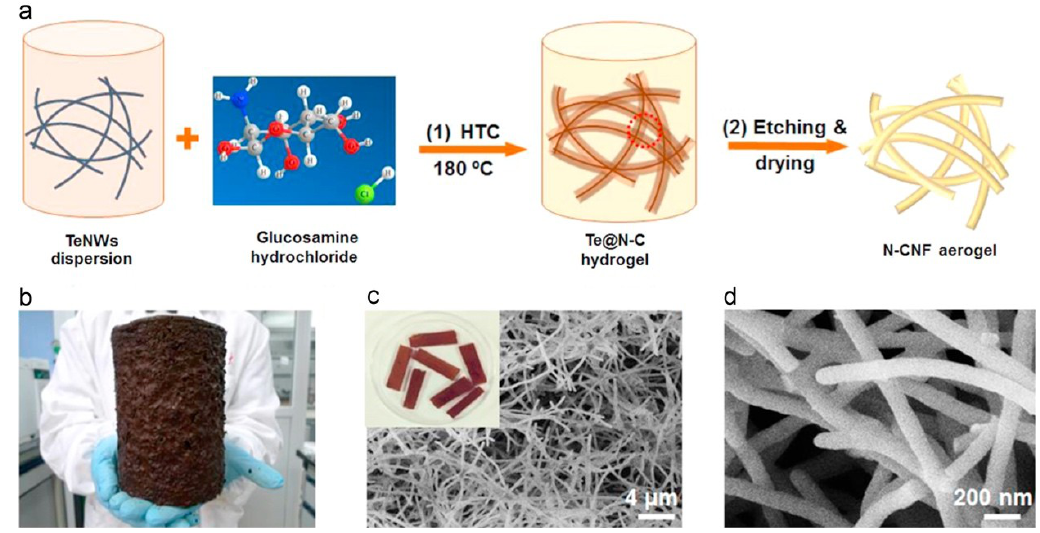
Figure 8. ( a ) HTC synthesis of nitrogen‐doped carbon nanofiber aerogels; ( b ) image of large‐scale quantities of such a product, and ( c ) and ( d ) SEM micrographs of images at different magnifications. Reproduced from [107], copyright Elsevier, 2015.